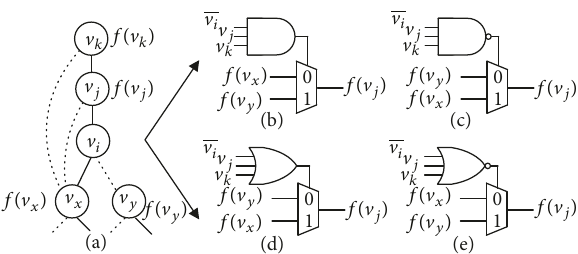
Figure 4: One case of Theorem 4 and relative feature structures: (a) one case of BDD subgraph, (b) AND3, (c) NAND3, (c) OR3, and (d)